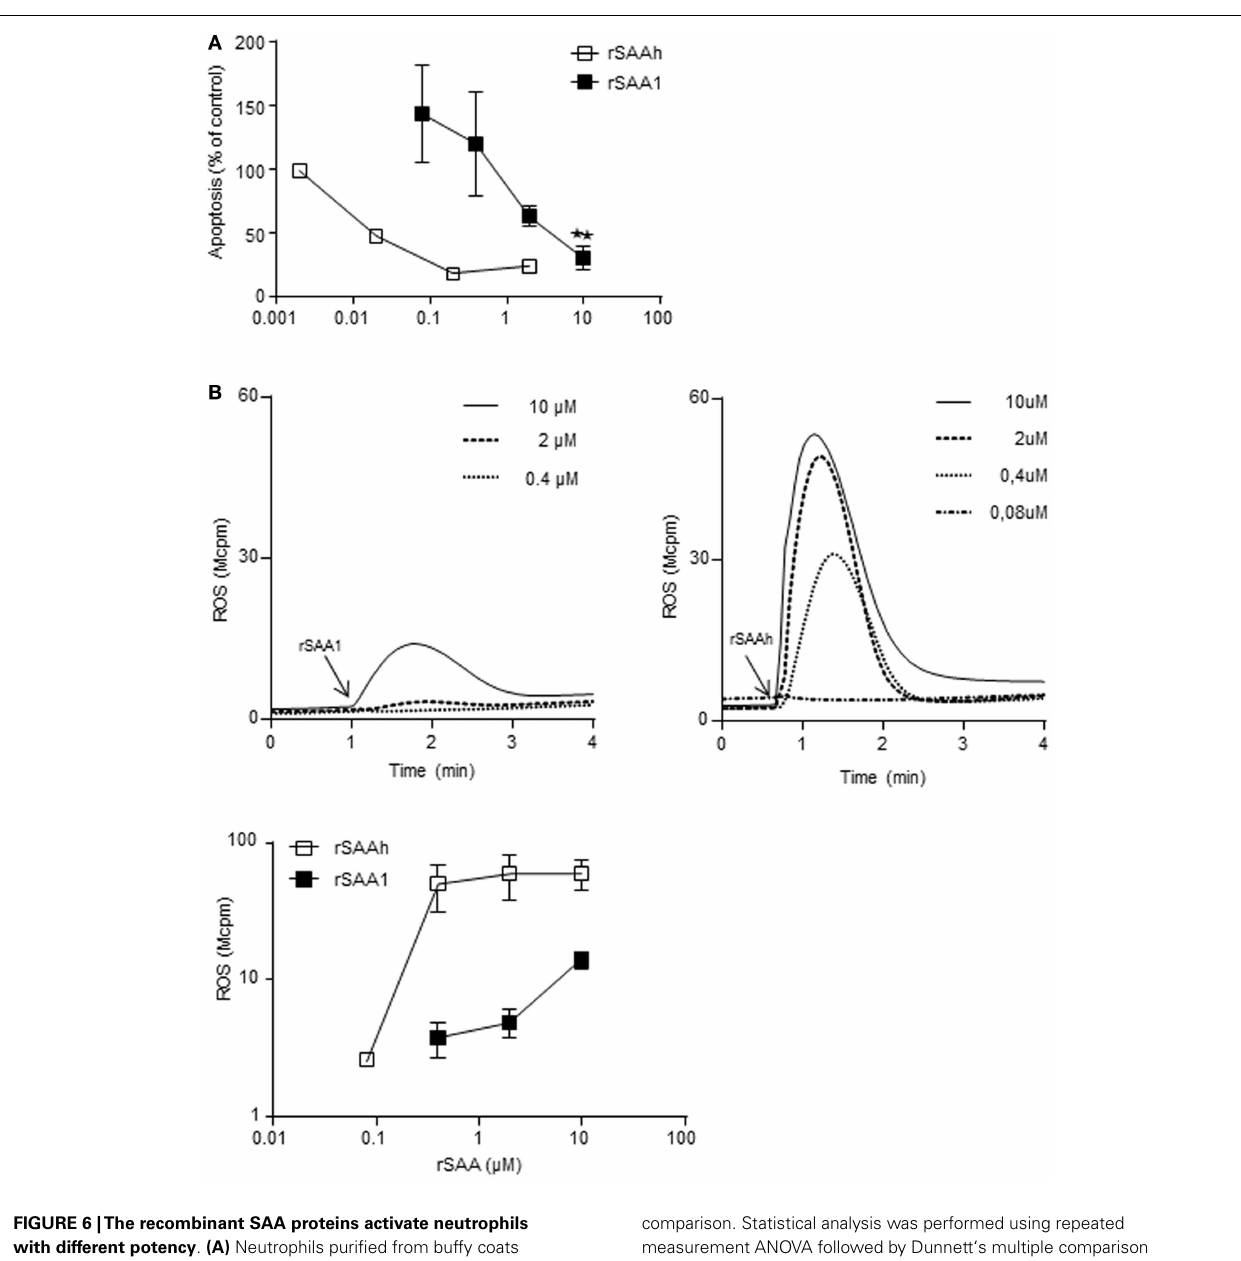
FIGURE 6 |The recombinant SAA proteins activate neutrophils with different potency . (A) Neutrophils purified from buffy coats were incubated for 20h with addition of medium, or rSAA1 (filled squares; n = 3) at the indicated concentrations. Apoptosis was thereafter evaluated by flow cytometry on the basis of AnnexinV positive events. Shown for rSAA1 is mean ( ± SEM) and one representative experiment with rSAAh (open squares) is shown for